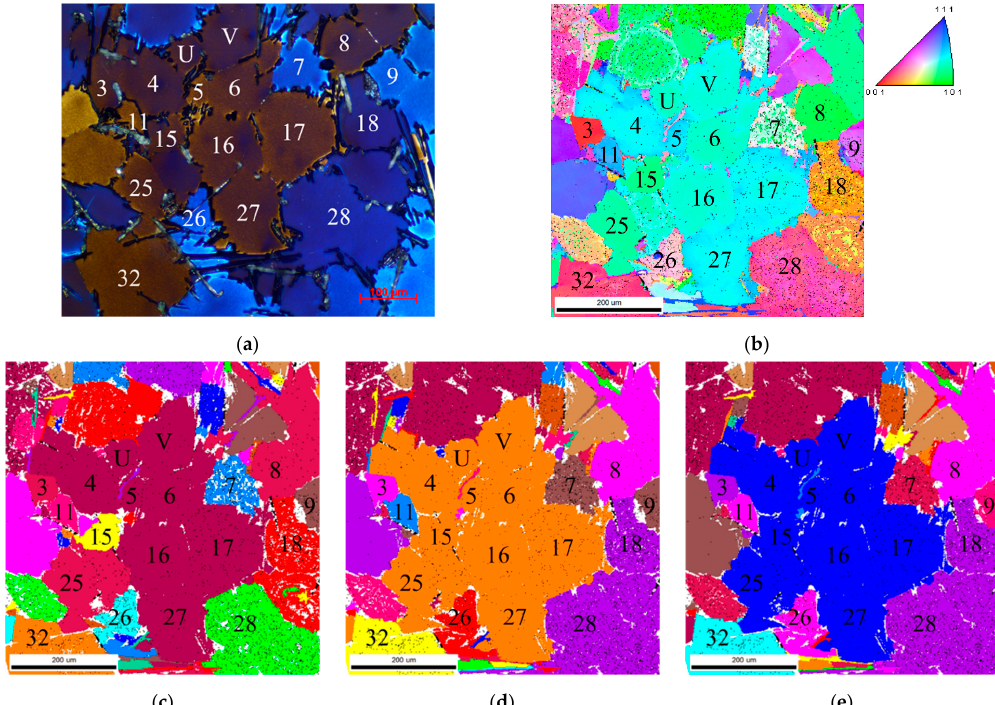
Figure 6. As-cast EMS billets, sand mold, poured at 630 °C; ( a ) polarized light image with sensitive tint plate, polished and anodized with Barker’s reagent, ( b ) IPF map, ( c ) 5° grain map, ( d ) 10° grain map, ( e ) 15° grain map. Table 4. EBSD data for as-cast EMS billets, sand mold, poured at 630 °C (Y, Yes; N, No).